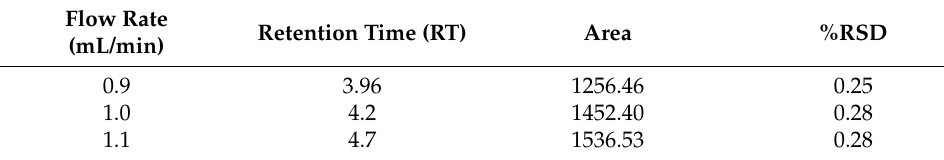
Table 3. Robustness with varied flow rates (AKH Conc: 100 µ g/mL).